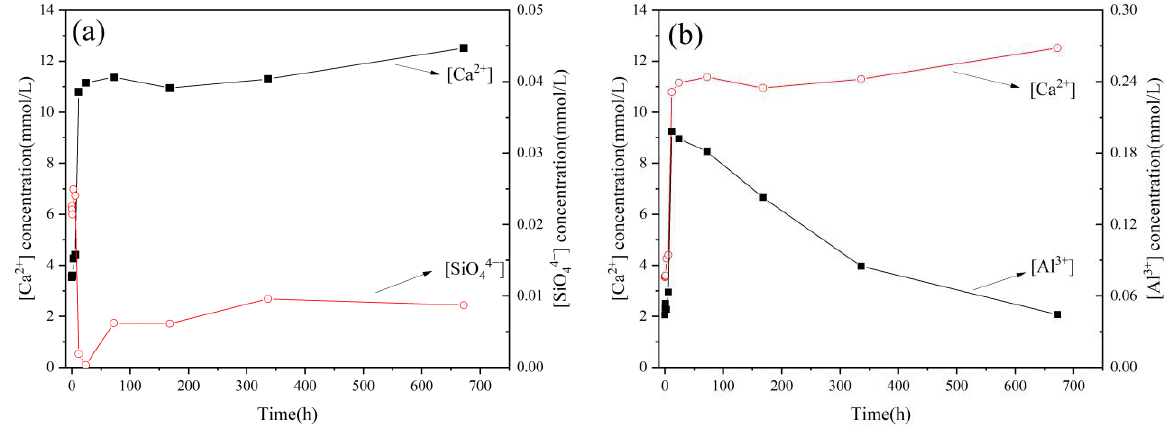
Figure 13. Ionic concentration of FCG-3: ( a ) Ca 2+ and SiO 44 − ; ( b ) Ca 2+ and Al 3+ .